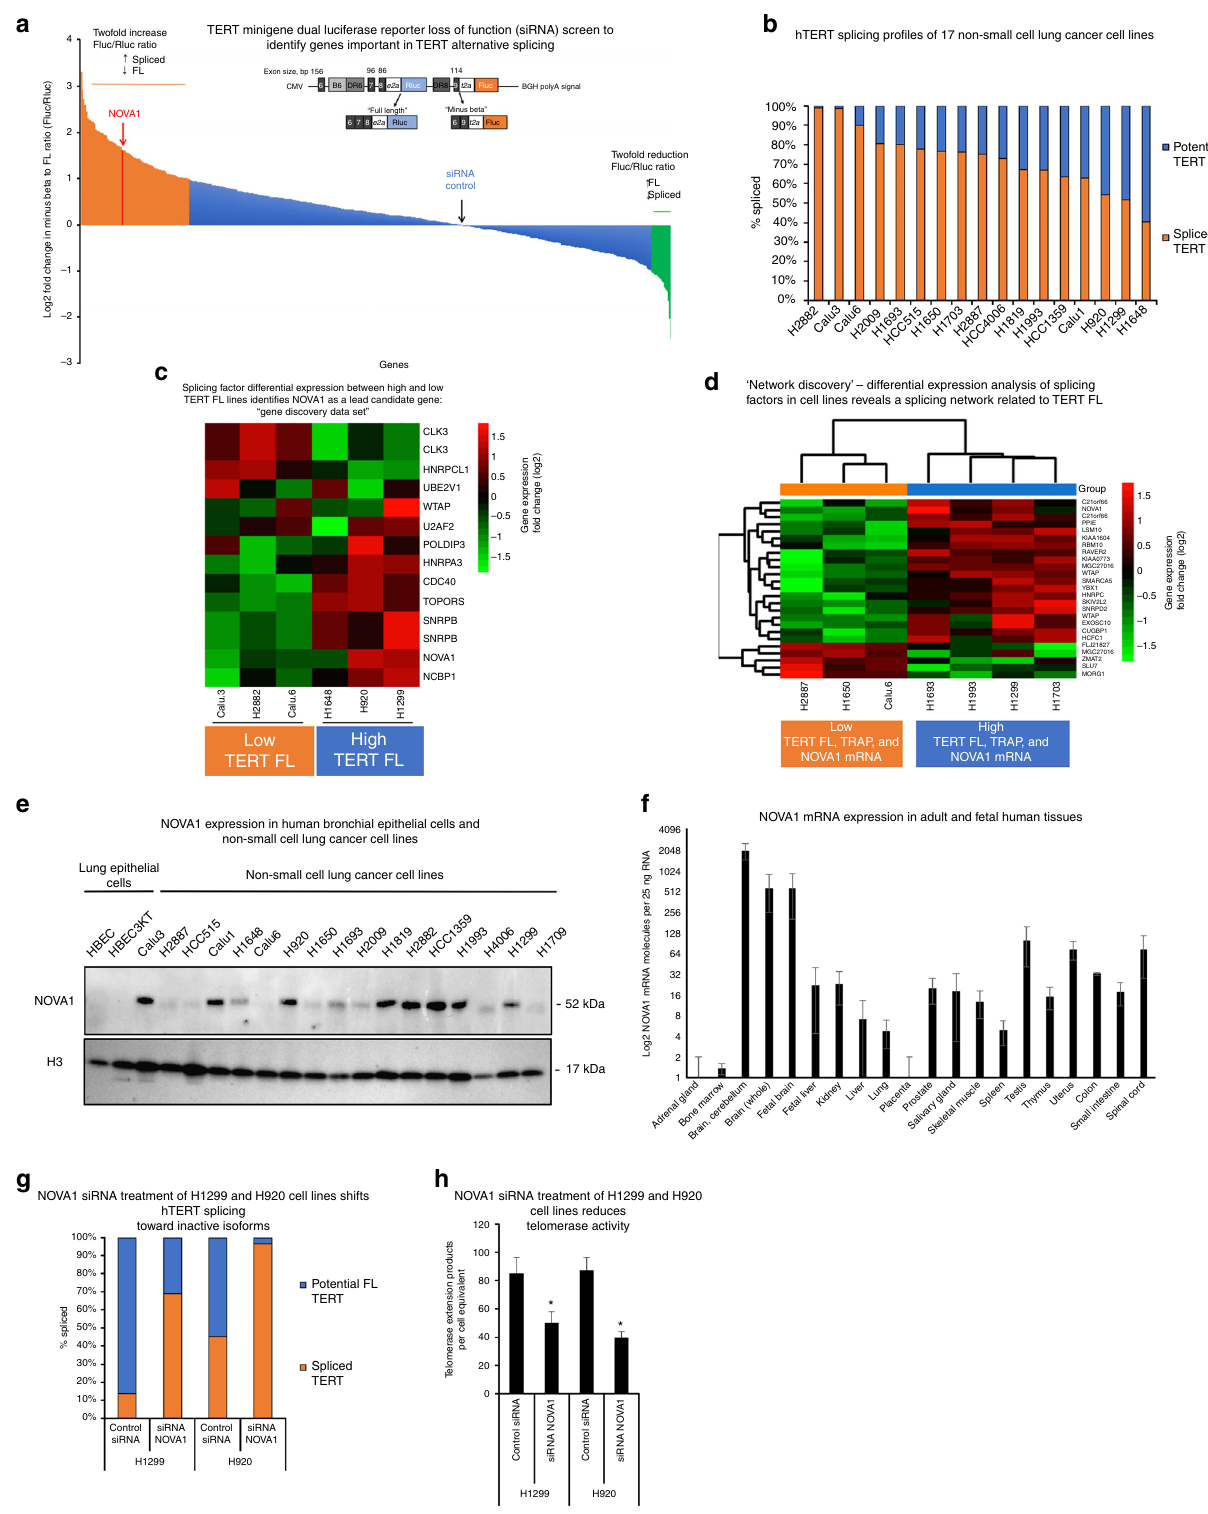
(differential expression analysis ( t tests), false-discovery rate corrected with Benjamini-Hochberg procedure) to the amount of potential FL hTERT as measured by our splice isoform assays. This analysis revealed 12 genes whose expression signi fi cantly correlated to the amount of FL hTERT (heatmap shows differ- ential expression of the 12 genes that correlated to hTERT